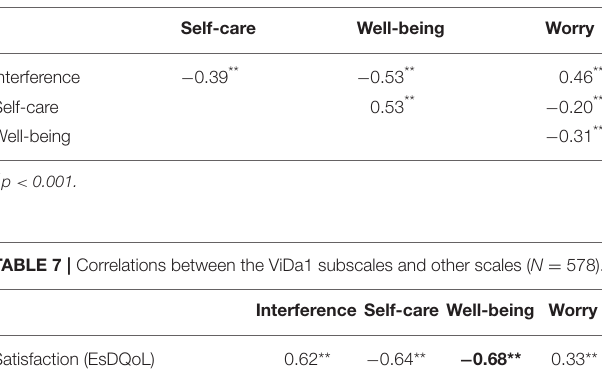
TABLE 6 | Correlations between the ViDa1 subscales ( N = 578).